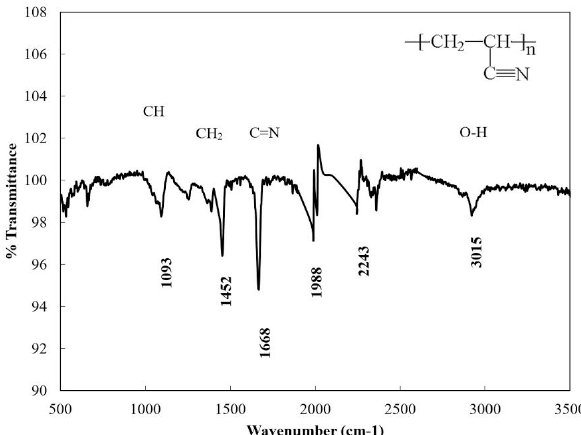
Figure 2. The Fourier Transform Infrared Spectroscopy (FTIR) Spectra of the Polyacrylonitrile fibers prior to carbonization.